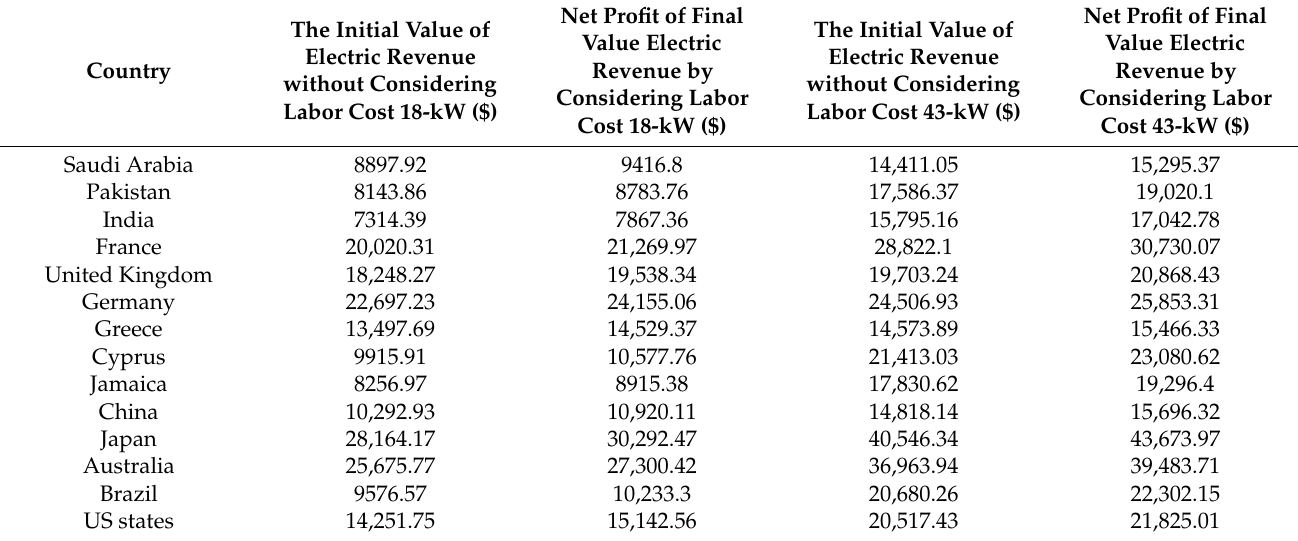
Table 13. The original and final rate returns associated with the substituting modules of the 10 × 10 PV arrays, taking into account the greatest economic advantage per